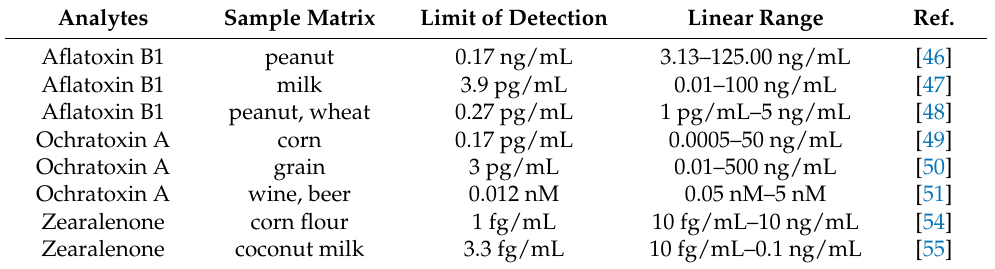
Table 1. Brief summary of ECL biosensors for the mycotoxin sensing in food samples.